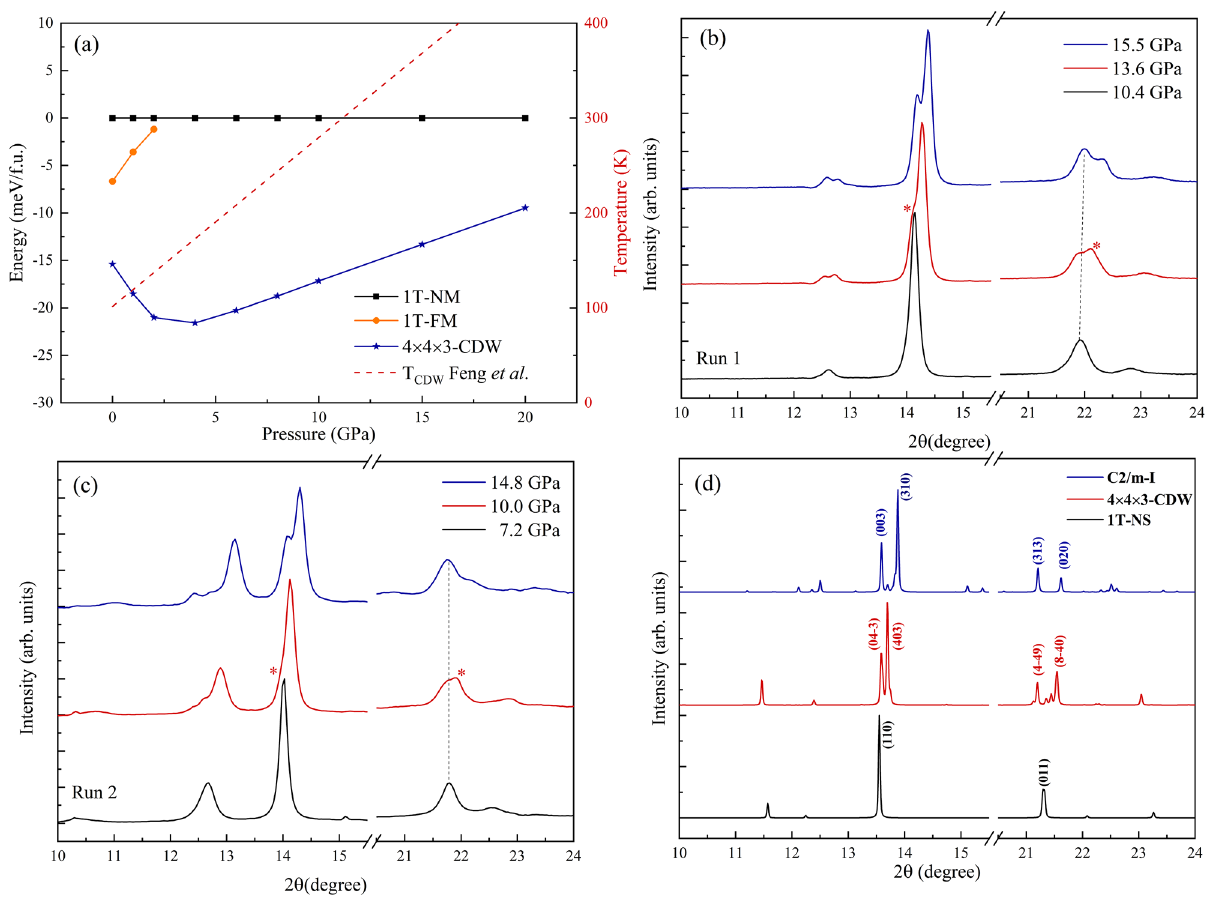
Figure 2. ( a ) Enthalpy curves of ferromagnetic 1 T -VSe 2 ( 1T -FM) and the 4a × 4a × 3c CDW superstructure relative to the nonmagnetic VSe 2 as a function of pressure. Enthalpies are given per formula unit. The pressure- dependent T CDW from Ref. 22 is added with Y-axis on the right side of the figure. ( b , c ) XRD pattern for the two runs of experiments, the indication of CDW order are marked by red asterisk. ( d ) Calculated XRD pattern for the C2/m , CDW, and 1 T -VSe 2